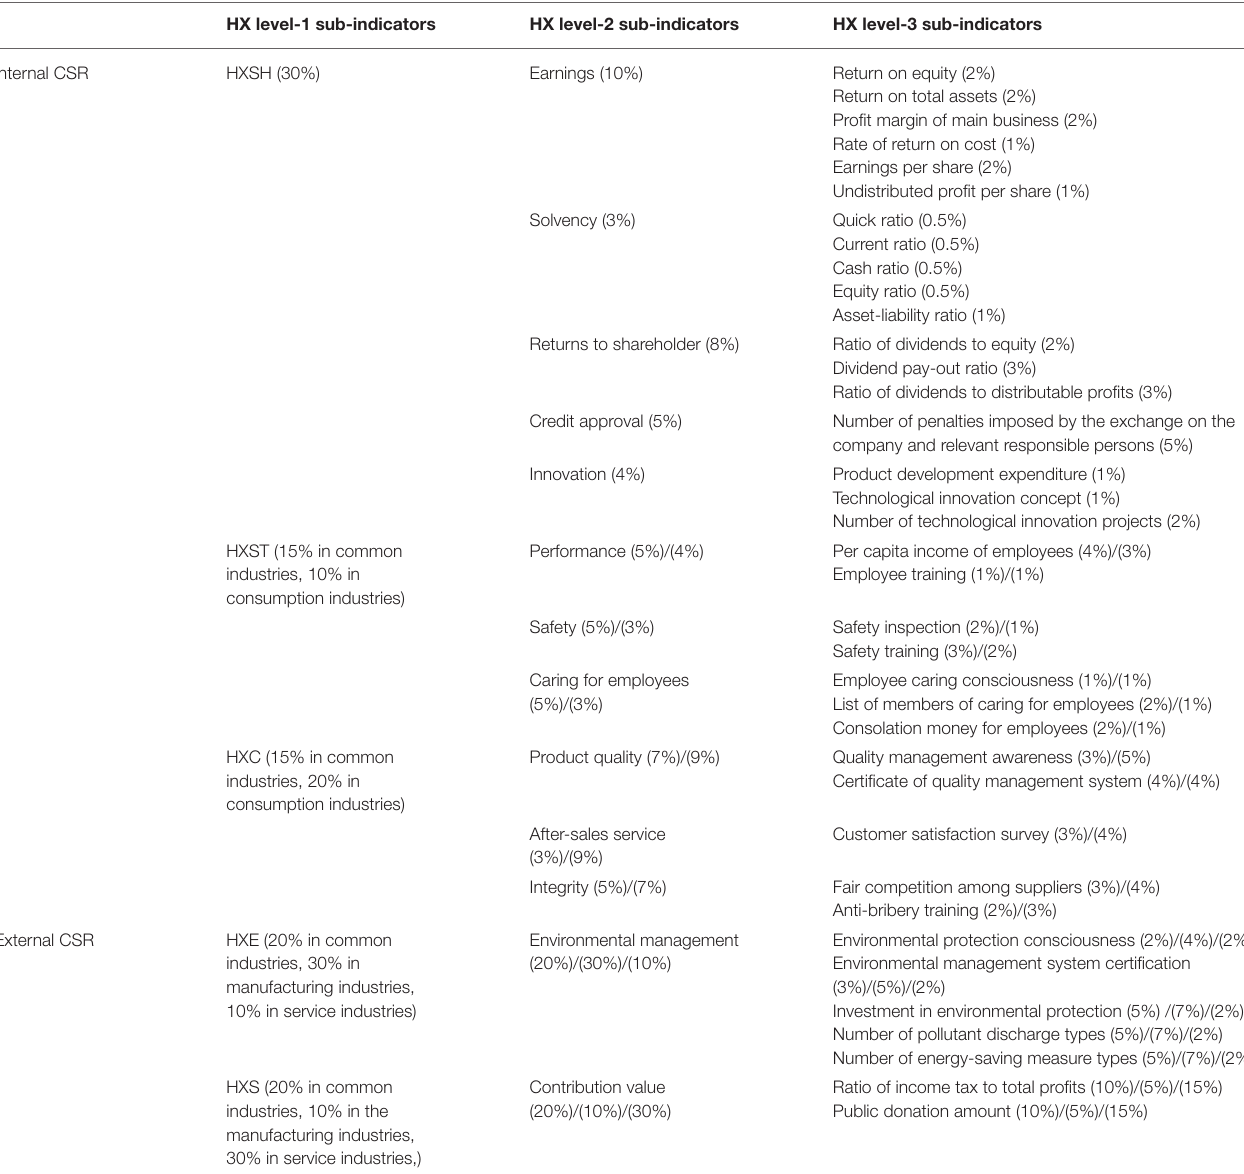
TABLE 1 | Hexun (HX) index system